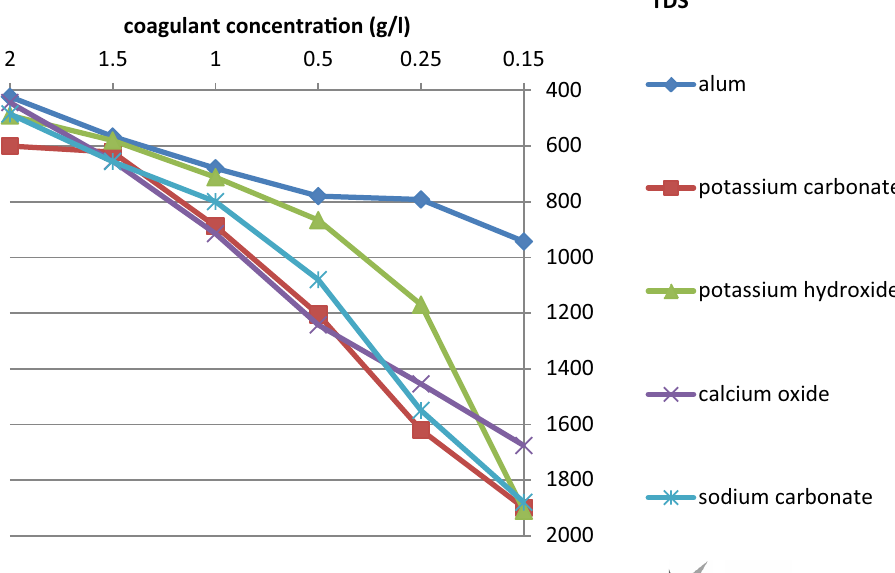
Fig. 4 TDS at varying doses of